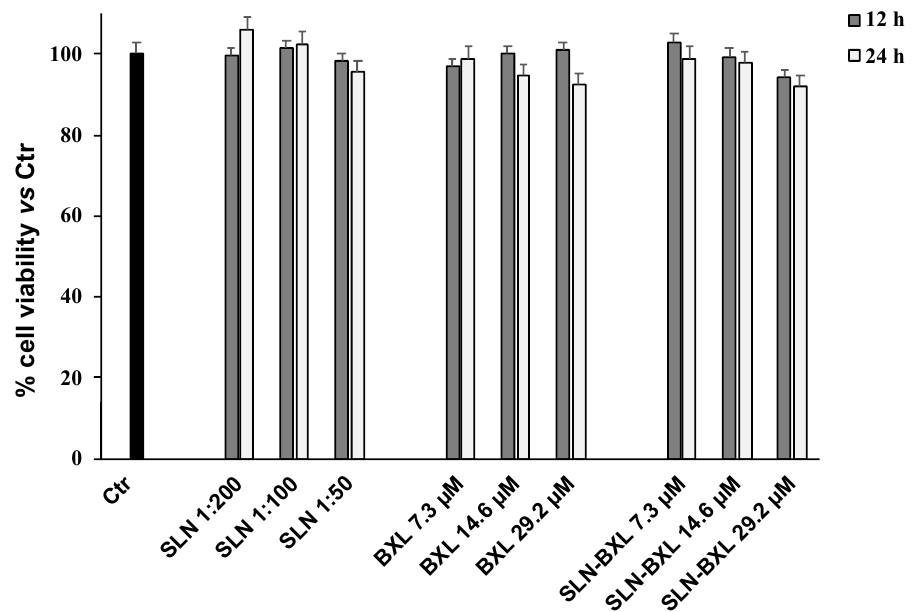
Figure 5. Cell viability in HFF-1 untreated (Ctr) and treated with empty SLN, BXL, and SLN-BXL at different concentrations. Values are expressed as mean ± S.D. of four experiments in triplicate.